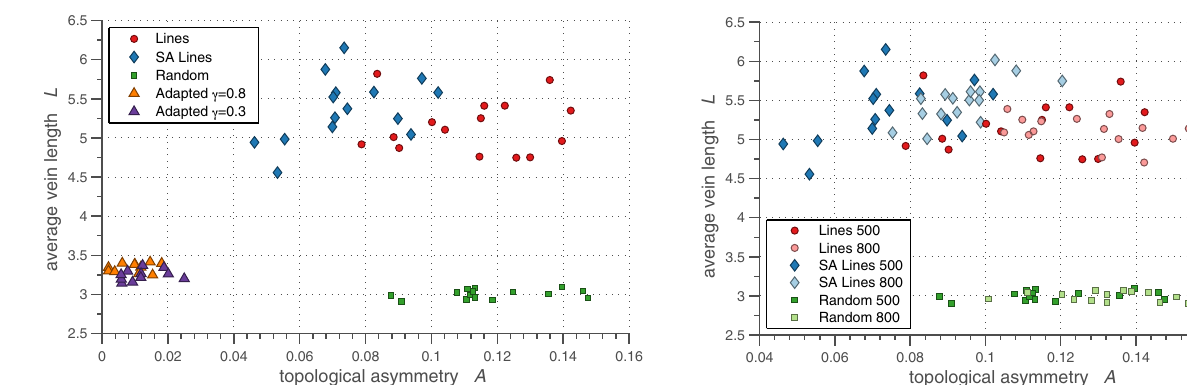
FIG. 12. Average vein length L versus topological asymmetry A for various edge-weight assignment models on random 3-regular graph topologies. The number of nodes on each graph was approximately N ≃ 500 or N ≃ 800 . Blue: SA lines 500; light blue: SA lines 800; red: lines 500; pink: lines 800; green: random 500; and light green: random 800. L and A are not sensitive to the graph size.